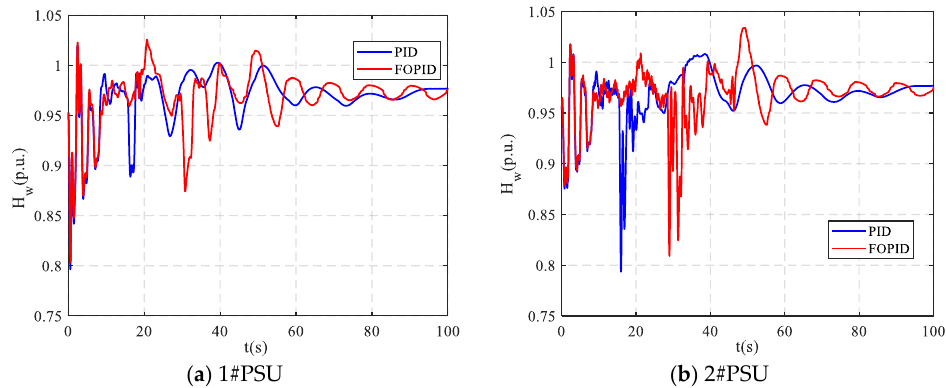
Figure 15. The flow dynamic curves of the two PSUs.